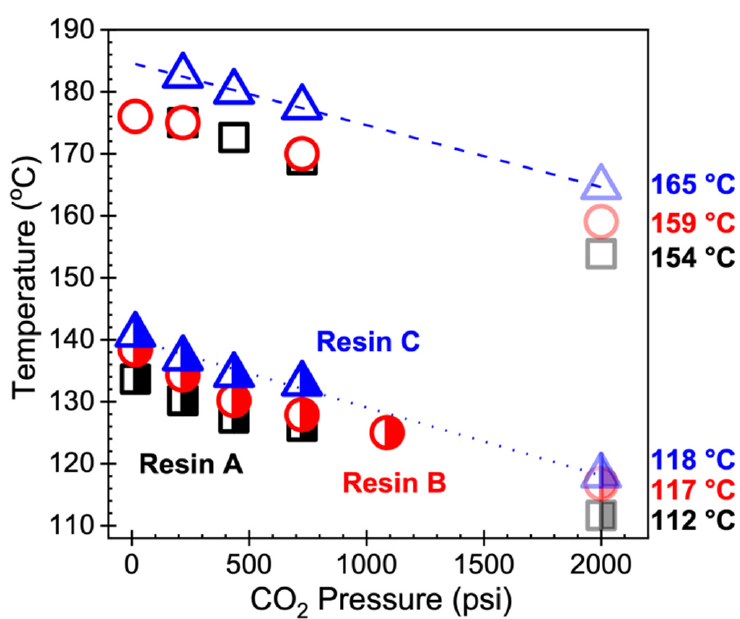
Figure 4. HP-DSC measurements of the end melting point (open) and onset crystallization temperature (half-filled) with respect to CO 2 pressure. Data points at a CO 2 pressure of 2000 psi were estimated using linear extrapolation (applicable up to 3600 psi [32] for T c,onset (dotted line) and 2000 psi for T m,end (dashed line) [33]).